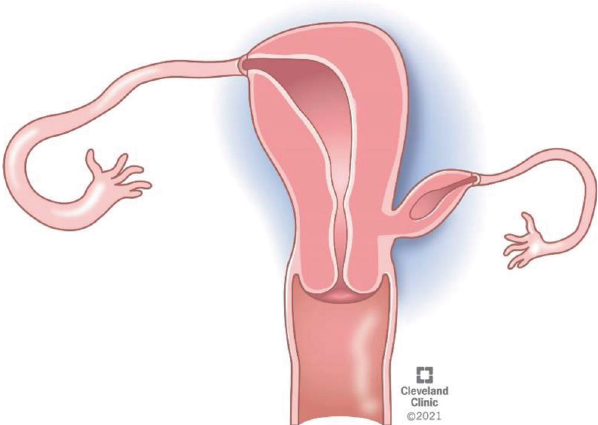
Figure 1: Unicornuate uterus with noncommunicating cavitary rudimentary